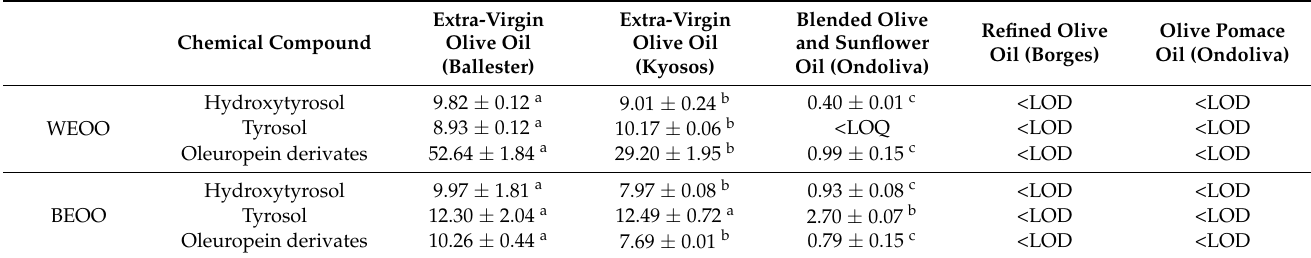
Table 2. Contents of followed compounds (mg/L) in WEOO and